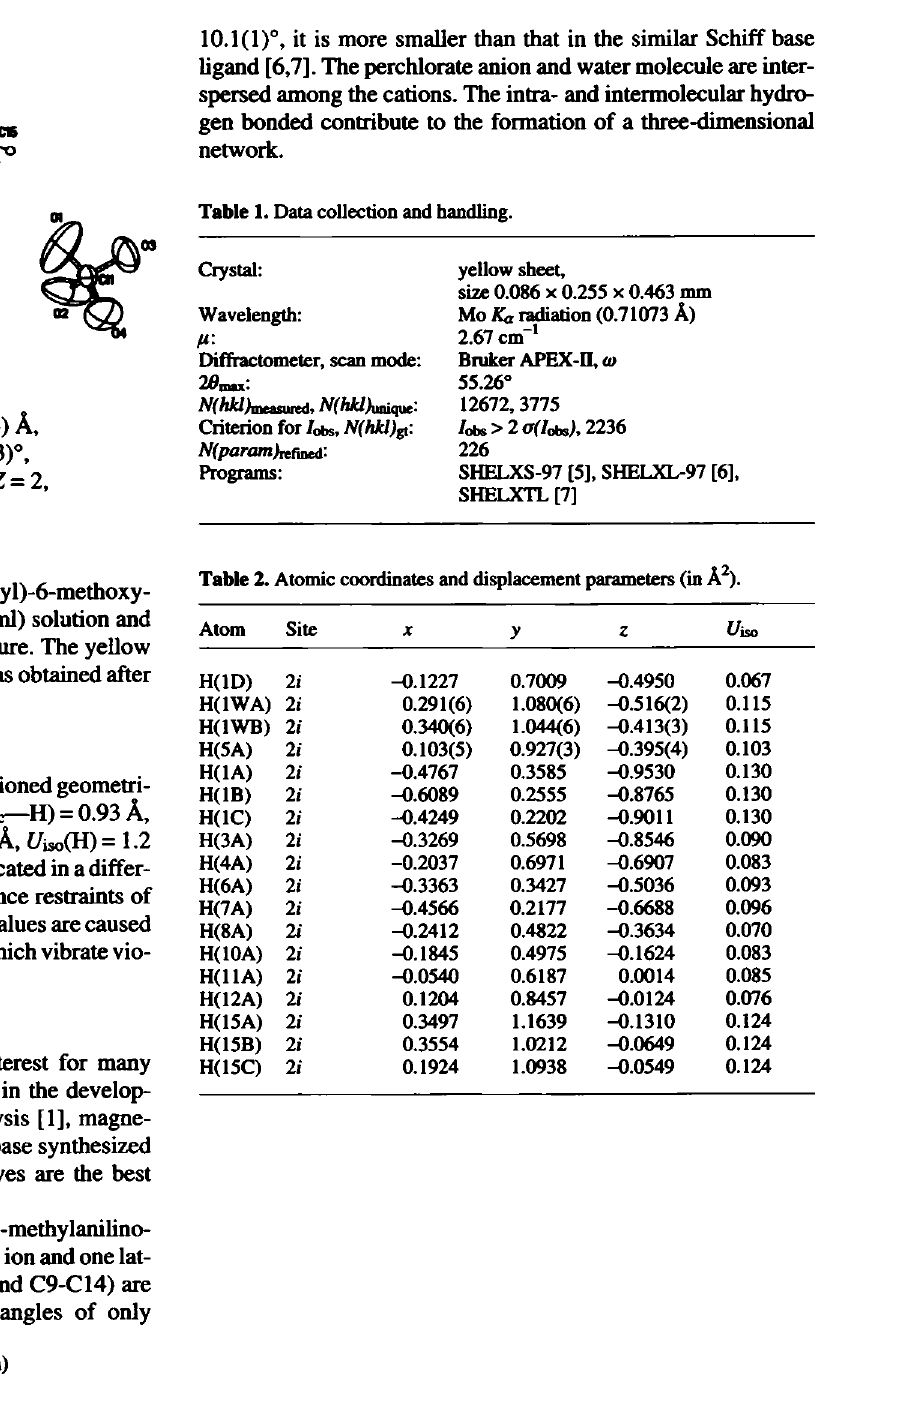
Table 1. Data collection and handling.